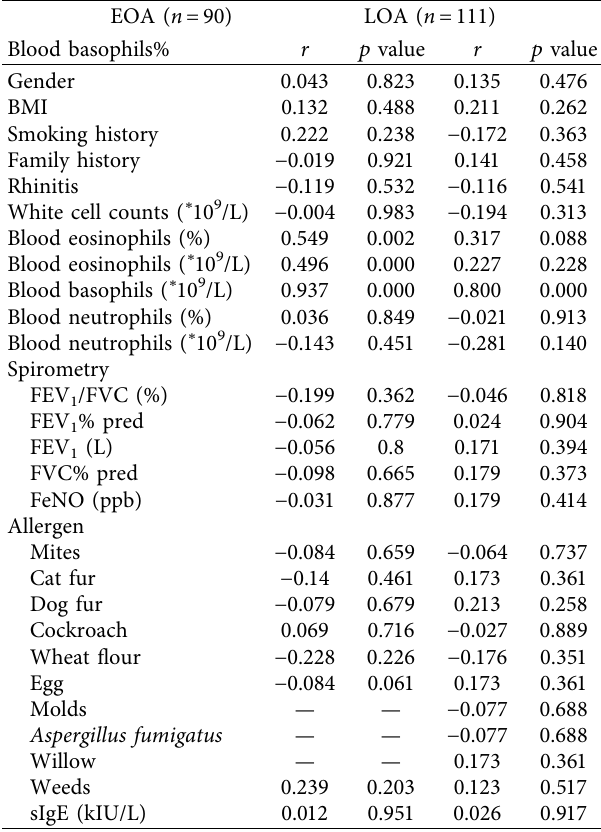
Table 3: Relationship between blood basophils (%) and clinical